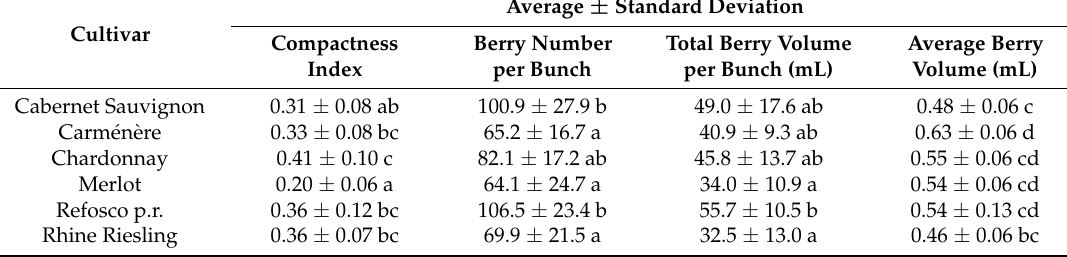
Table 2. Cultivar bunch-traits recorded in coincidence with the Lobesia botrana egg-hatching peak of the second generation. Different small letters among cultivars within each column indicate significant differences according to Tukey’s test at the 0.05 level.